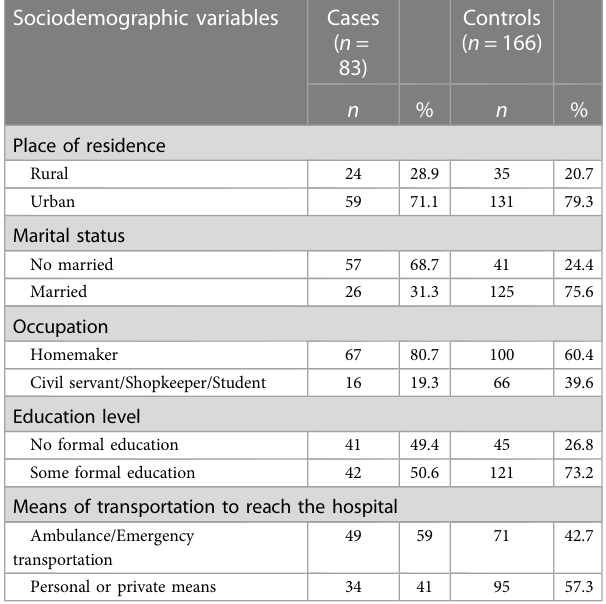
TABLE 1 Sociodemographic factors associated with intrapartum stillbirth. Sociodemographic variables